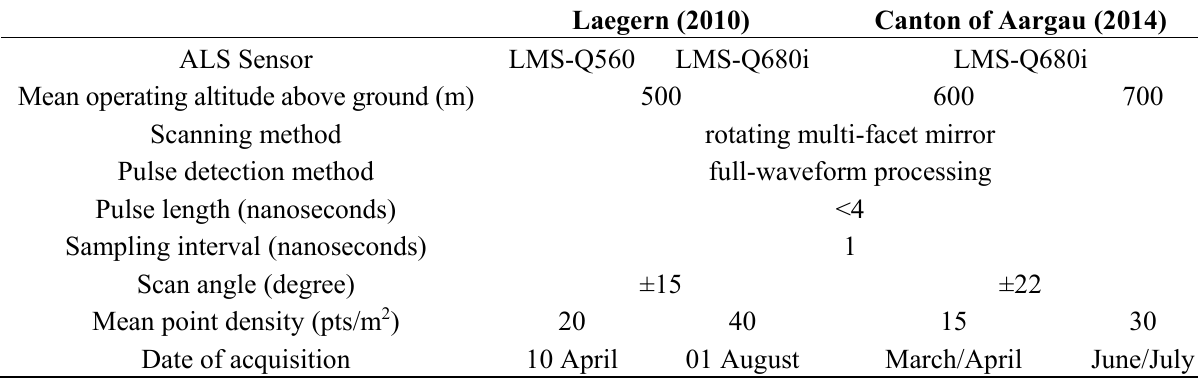
Table 1. Used sensor specifications of RIEGL’s airborne laser scanner LMS-Q560 and LMS-Q680i (RIEGL Laser Measurements Systems GmbH, Austria) for the Laegern site and Canton of Aargau.